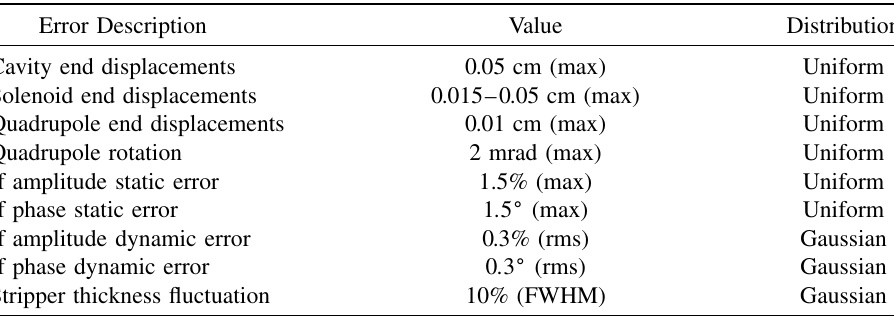
TABLE I. Errors and their typical values used in the simulations. For rf errors we consider both static and dynamic (jitter) errors. Static errors are essentially measurements errors while dynamic error are the fluctuation in time in both amplitude and phase of the rf. A corrective steering is applied to correct for misalignments. The rf static errors are also corrected for with a residual error in the order of the dynamic